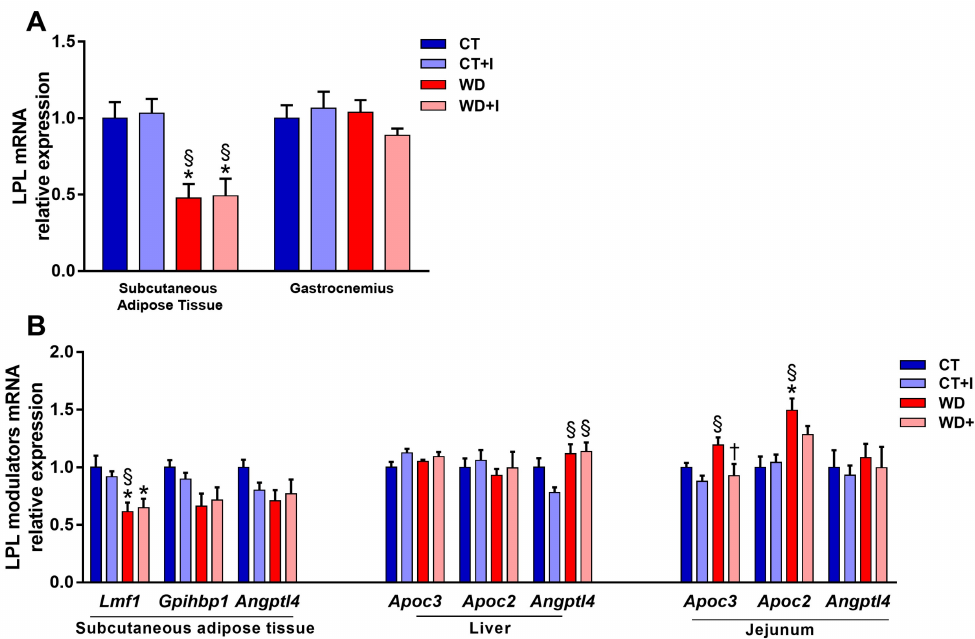
Figure 5. Lpl mRNA expression in the muscle and subcutaneous adipose tissue ( A ). Level of mRNA expression of post-translational regulators of LPL activity ( B ). Data are presented as mean ± SEM and analyzed with two-way ANOVA followed by Tukey post hoc tests. * p < 0.05 versus CT, § p < 0.05 versus CT + I, † p < 0.05 versus